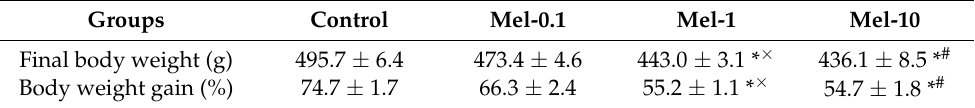
Table 1. Dose-dependent effects of melatonin on body weight in Zücker diabetic fatty